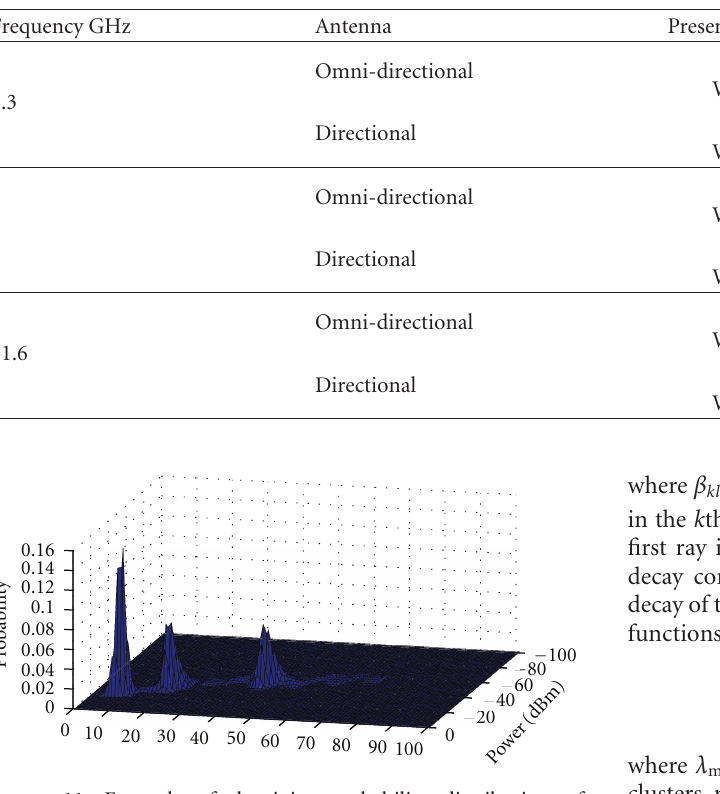
Figure 11: Example of the joint probability distribution of amplitude and time of arrival